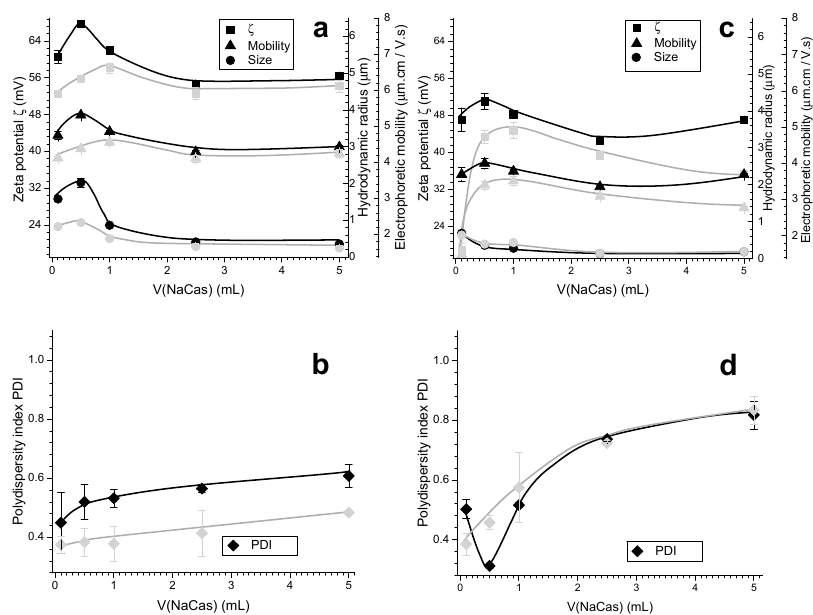
Figure 4. Zeta potential ζ , electrophoretic mobility, hydrodynamic radius (size) and its polydispersity index PDI respectively obtained for the experiments of the Case I (chitosan in excess): (i) sodium caseinate added to HMW CHI of low DA = 3% ( a , b ); (ii) sodium caseinate added to deacetylated-LMW CHI of low DA = 3% ( c , d ). Black curves show the polyelectrolyte complex PEC characteristics obtained in the first week; grey curves show the results obtained after two weeks aging at room